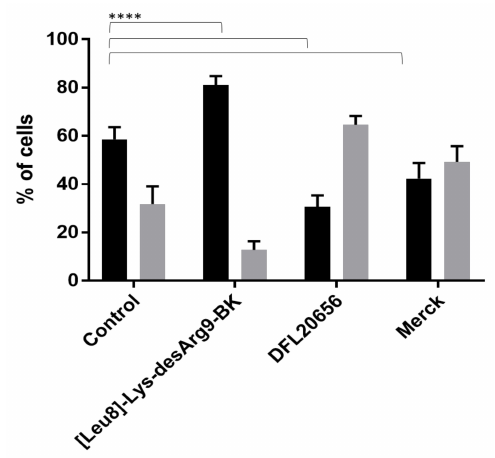
Figure 6. Analysis of B1 expressing cells: IMR90 cells were treated with selected inhibitors for 30 (cid:48) at [2000 nM], subsequently the peptidic B1 agonist, Lys-desArg 9 -BK, was added and incubated for an additional 30 (cid:48) . Steady-state IMR90 (control) presented a distribution of B1 expressing cells (in black) and B1 negative cells (in grey). When antagonists were added the distribution changed. In particular, the peptidic antagonist [Leu 8 ]-Lys-desArg 9 -BK, stabilized the presence of B1 upon the membrane while Domp é DFL20656 increased the percentage of B1-negative cells thus promoting B1 receptor internalization. The data represent the mean of 5 replicates. All data were presented as the mean ± SEM. Bonferroni-Dunn post hoc test was used. p < 0.05 was considered representative of significant di ff erences. **** p < 0.0001.